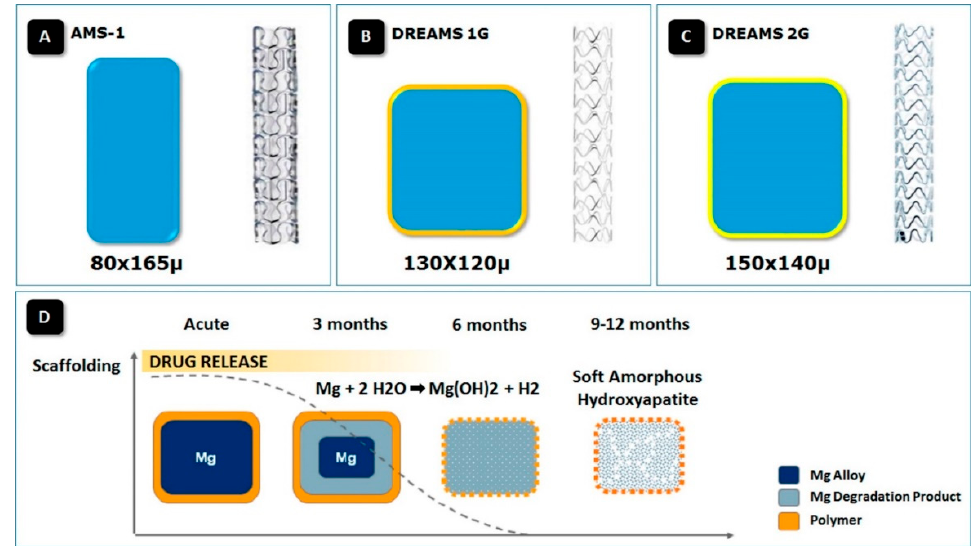
Figure 1. ( A ) Schematic cross-sectional profile of magnesium sca ff olds struts of ( A ) uncoated, non-eluting, AMS-1 with 80 × 165 µ ; ( B ) DREAMS 1st Generation (DREAMS 1G) with 130 × 120 µ struts and ( C ) DREAMS 2nd generation (2G) with 150 × 140 µ struts. The poly(lactide-co-glycolide)-coating with paclitaxel elution of the DREAMS 1G sca ff old is indicated by the thin light orange layer. The PLA coating with sirolimus elution of the DREAMS 2G sca ff old is indicated by the thin dark orange layer; and ( D ) Schematic representation of the resorption process in the drug-eluting absorbable magnesium sca ff old. The release of the anti-proliferative drug occurs within the first 3 months after device implantation. Hydrolysis of the sca ff old a ff ects the radial strength of the sca ff old, resulting in a gradual resorption of the device into a soft amorphous hydroxyapatite at 9 months follow-up. AMS-1, first-generation bare absorbable metal sca ff old; DREAMS, Drug-Eluting Absorbable Metal Sca ff old, (Reproduced from: Campos CM et al. Int. J. Mol. Sci. 2013, 14(12), 24492–24500.)